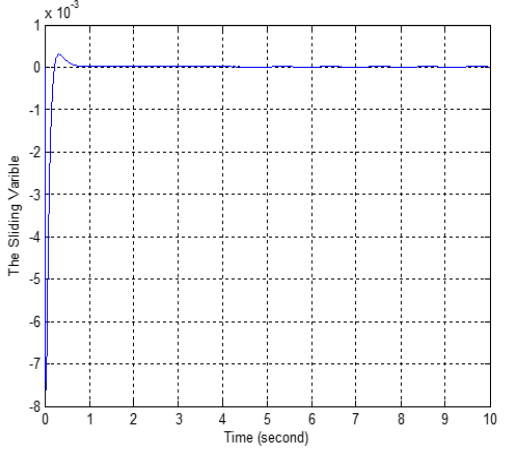
Fig. 26. The Sliding variable f vs. time of the ISMC.